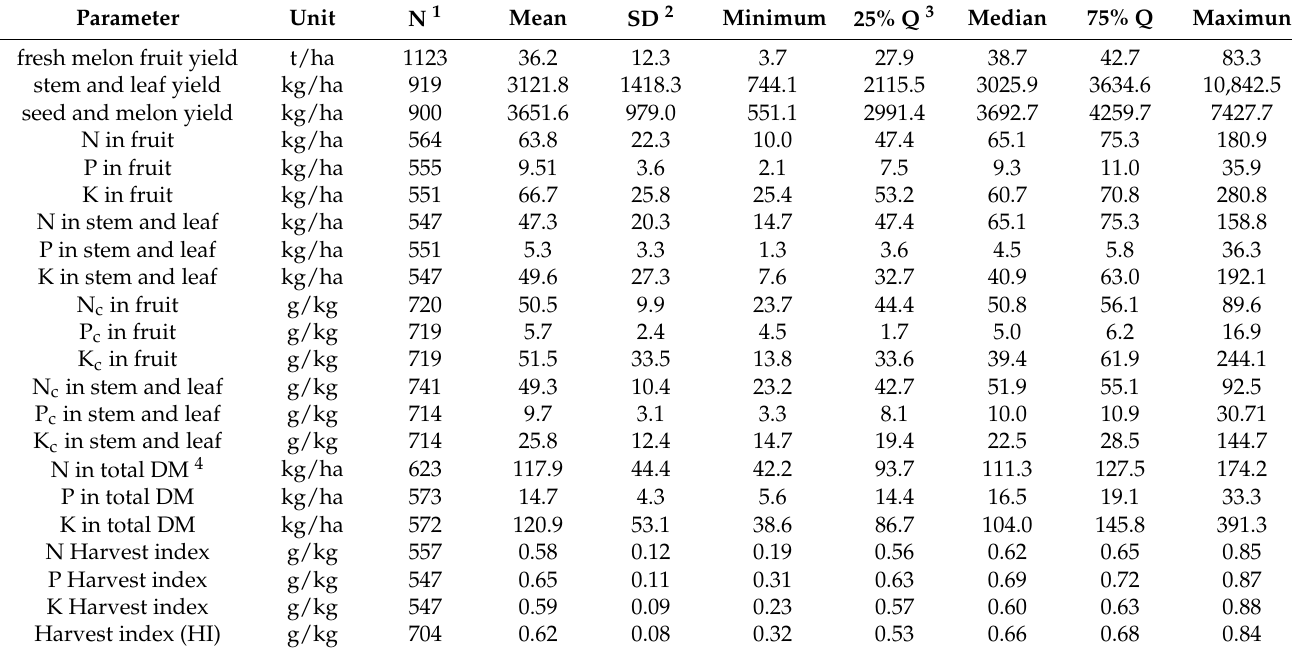
Table 3. Statistics of melon yield and stem and leaf yield; nutrient uptake in fruit; nutrient uptake in stem and leaf; N, P and K concentrations in fruit and stem and leaf; nutrient uptake in above-ground dry matter; and N, P and K harvest index